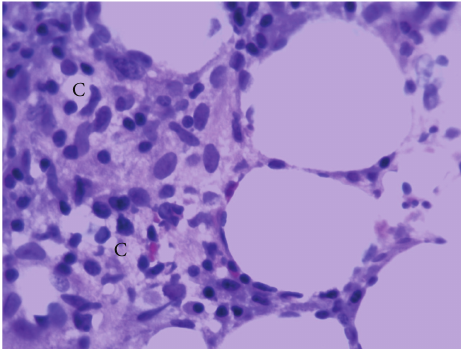
Figure 3: Nonnecrotizing granulomas (letter